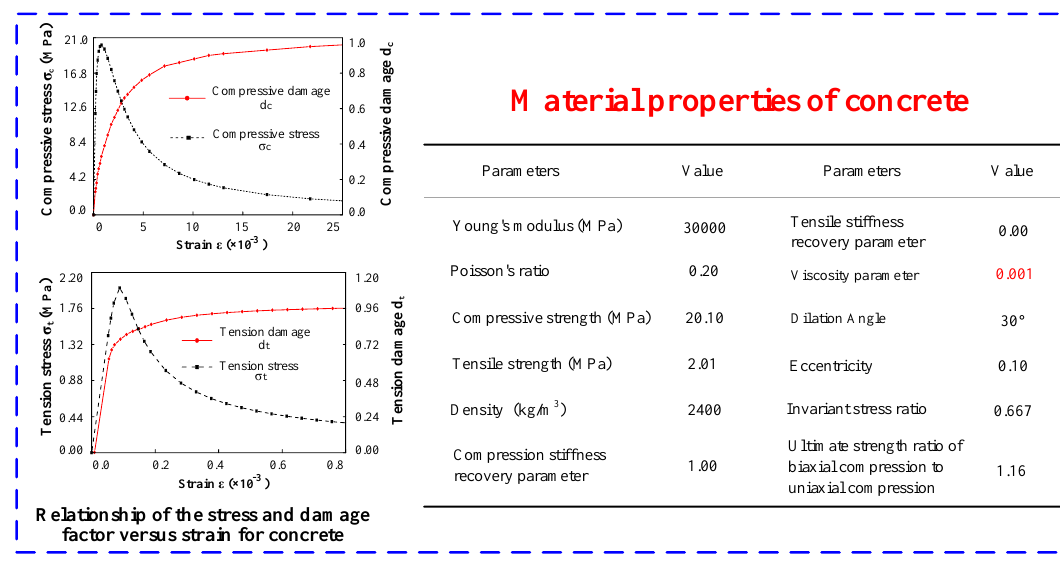
Figure 6. Material properties of the concrete structure. Considering the isotropic-hardening effects, the modified Menegotto-Pinto constitu- tive model [24,25] is adopted to simulate the dynamic behavior of the steel bar in this study, as shown in Figure 7. The stress–strain relationship represents the transition curve from a straight asymptote with a slope of E 0 (initial elastic modulus) to another asymptote with a slope of E 1 . Where b = E 1 / E 0 denotes the strain strengthening coefficient, R 0 is the curva- ture parameter affecting the shape of the transition curve from elastic to plastic-hardening. This model can accurately and efficiently reflect the Bauschinger effect under cyclic loads.